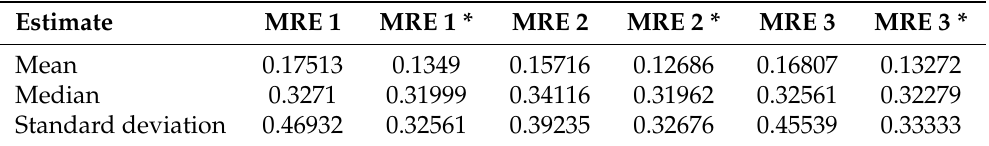
Table 4. Mean relative error of average values of onward HIV transmission statistics compared between benchmark data and after calibration with HIV epidemiology and sexual behaviour